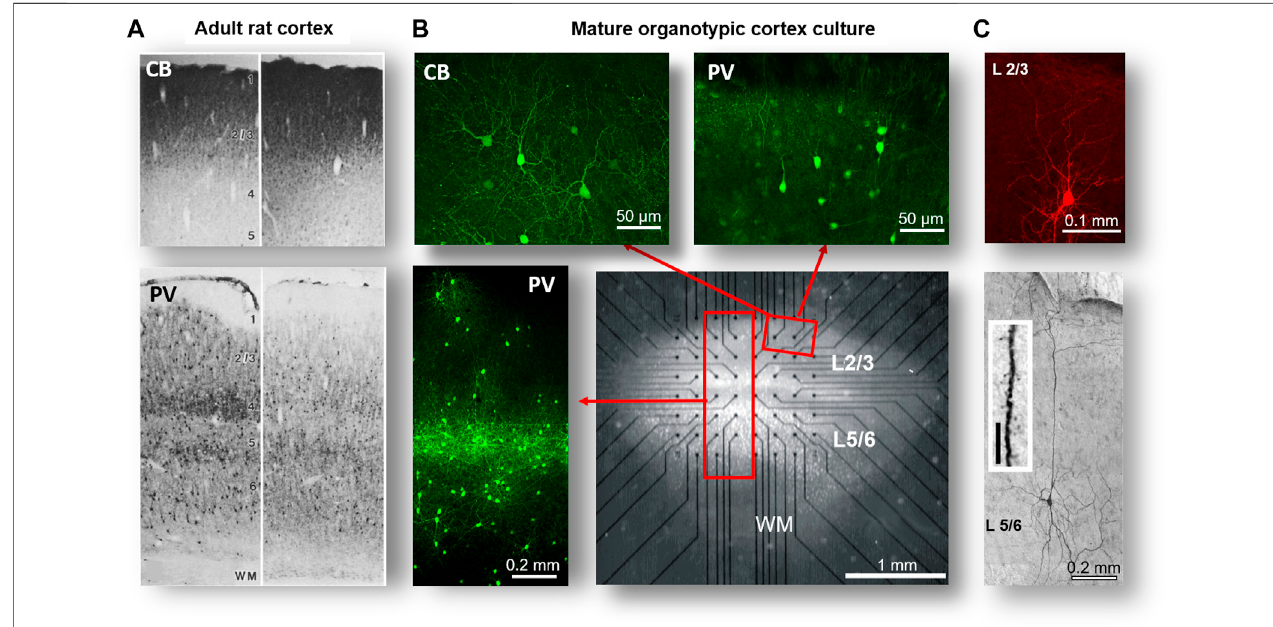
FIGURE1| Structuralmotifsofself-organization: corticallayers,pyramidalneurons,andinterneuronsinorganotypic cortexcultures. (A) Coronalsections fromthe brain in adult rats showing the somatosensory cortex ( left ) and motor cortex ( right ). Note high density of calbindin ( CB ) – positive interneuron stain typical for super fi cial layers( top ) andthe layer-dependentbands ofparvalbumin ( PV ) – positiveinterneurons indeep layers( bottom ). (B) Organotypic cortex cultureafter ∼ 4 weeks grown ona planar multielectrode array(MEA).Notetransparenthealthyneuraltissueof ∼ 4 mm 2 covering thearrayatathicknessof ∼ 100 – 200 µmand electrodes ( black dots ), conductors of the MEA. Composite images (red rectangles) indicating super fi cial layers (L2/3) that contain PV and CB-positive interneurons and deep layers (L5/6) with theirintensebandofPV-positiveinterneurons. WM :whitematterregion. (C) TypicalcellbodyanddendriticmorphologyofpyramidalneuronsfromL2/3andL5,thelatter withtheircharacteristicallylongandbranchedapicaldendrite. Inset :spinydendritetypical forpyramidalneurons( A reprintedwithpermissionfrom[165], B modi fi edwith permission from [14], and C modi fi ed with permission from [18]; Copyright 1998 Society for Neuroscience).